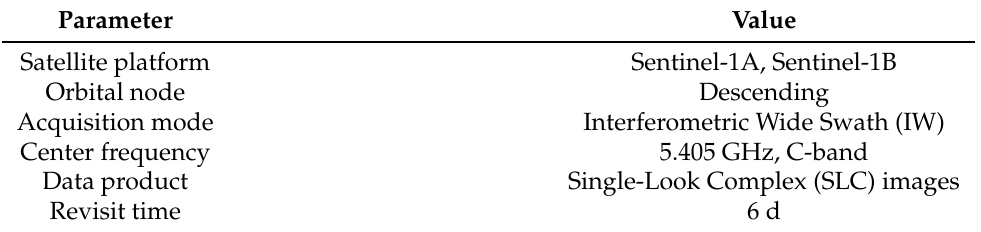
Table 1. Sentinel-1 platform and interferometric acquisition parameters.